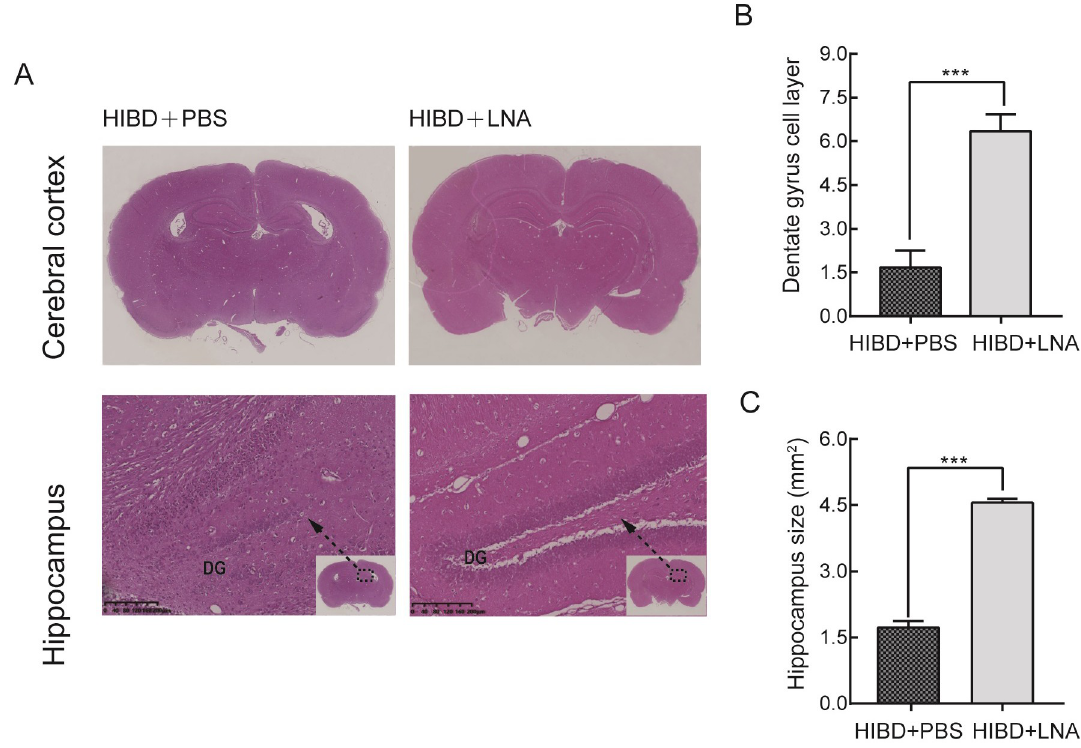
Fig 4. LNA-miR-9 attenuated brain tissue loss in HIBD rats. (A) Coronal sections stained with hematoxylin/eosin are shown. (B, C) Quantification of the size of the hippocampus and the layers of hippocampal dentate gyrus in the different groups. ��� P < 0.001 vs HIBD+PBS. N = 6 for HE